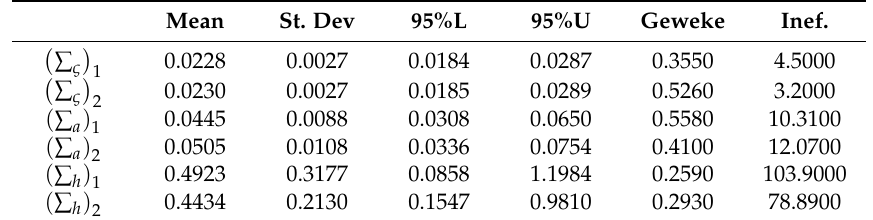
Table 5. Estimation of selected parameters in the TVP-VAR model (housing loans–housing prices). Mean St. Dev 95%L 95%U Geweke Inef.